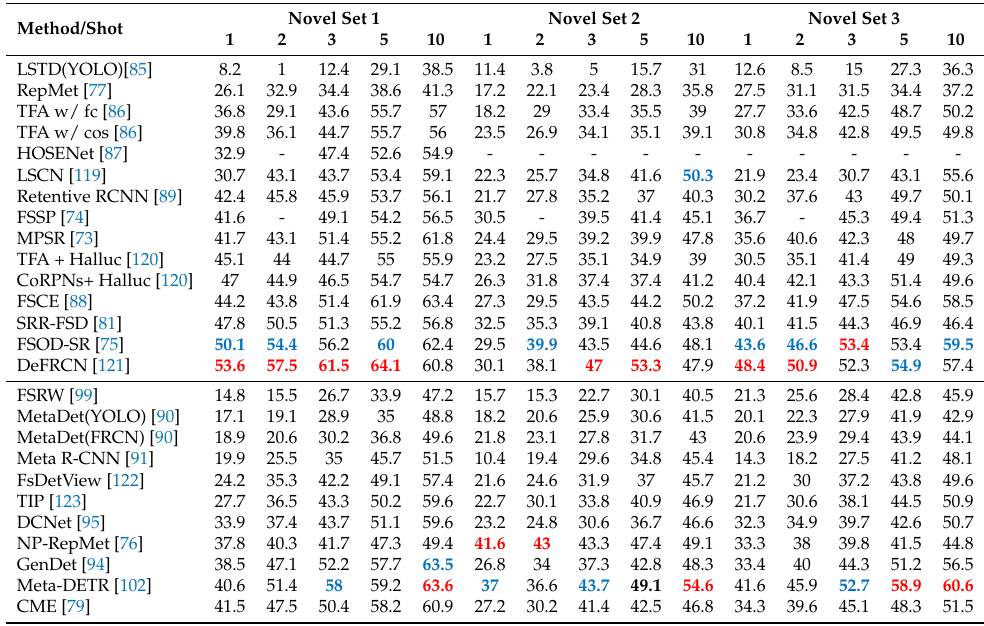
Table A2. FSOD performance (AP50 in %) on the PASCAL VOC 2007 test set . The upper half is transfer learning-based FSOD approaches, while the lower half refers to meta learning-based FSOD methods. Red, and blue indicate the state-of-the-art and the second-best, respectively. Novel Set 1 Novel Set 2 Novel Set 3